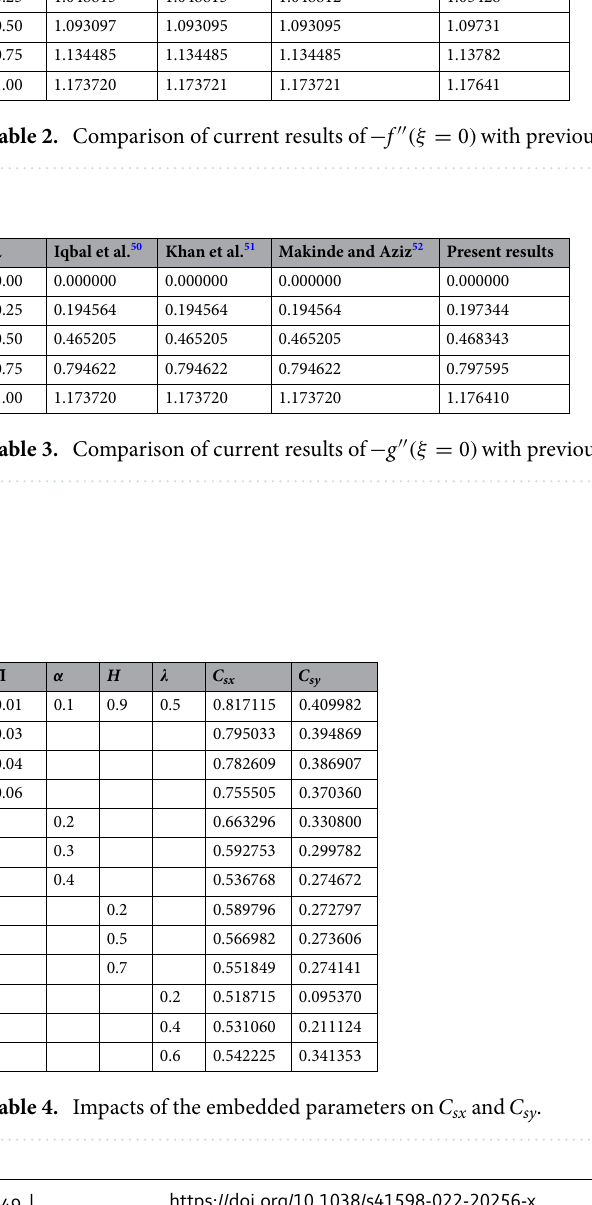
Table 2. Comparison of current results of